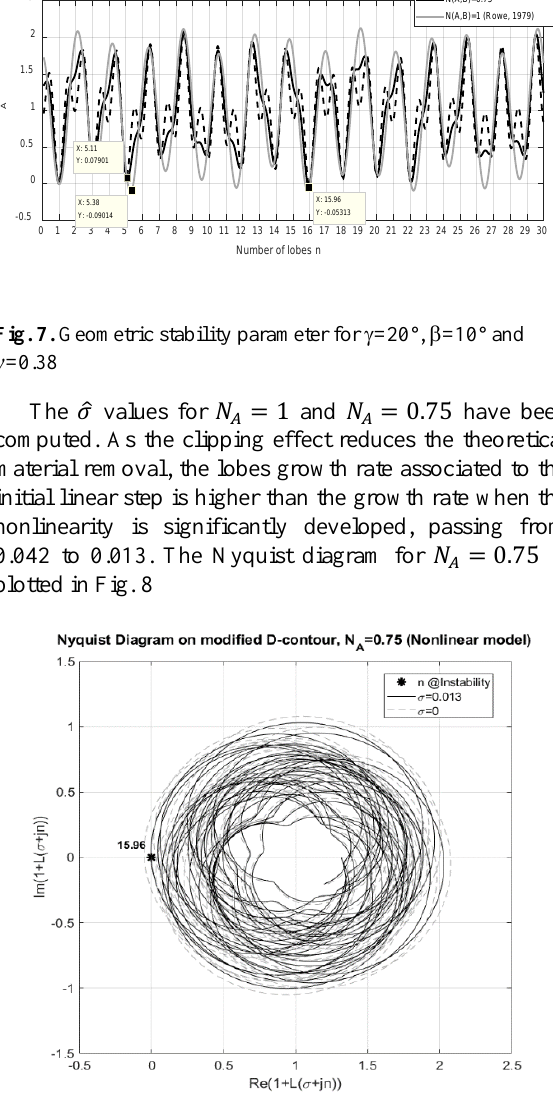
Fig. 10. The initial number of lobes of 5.3